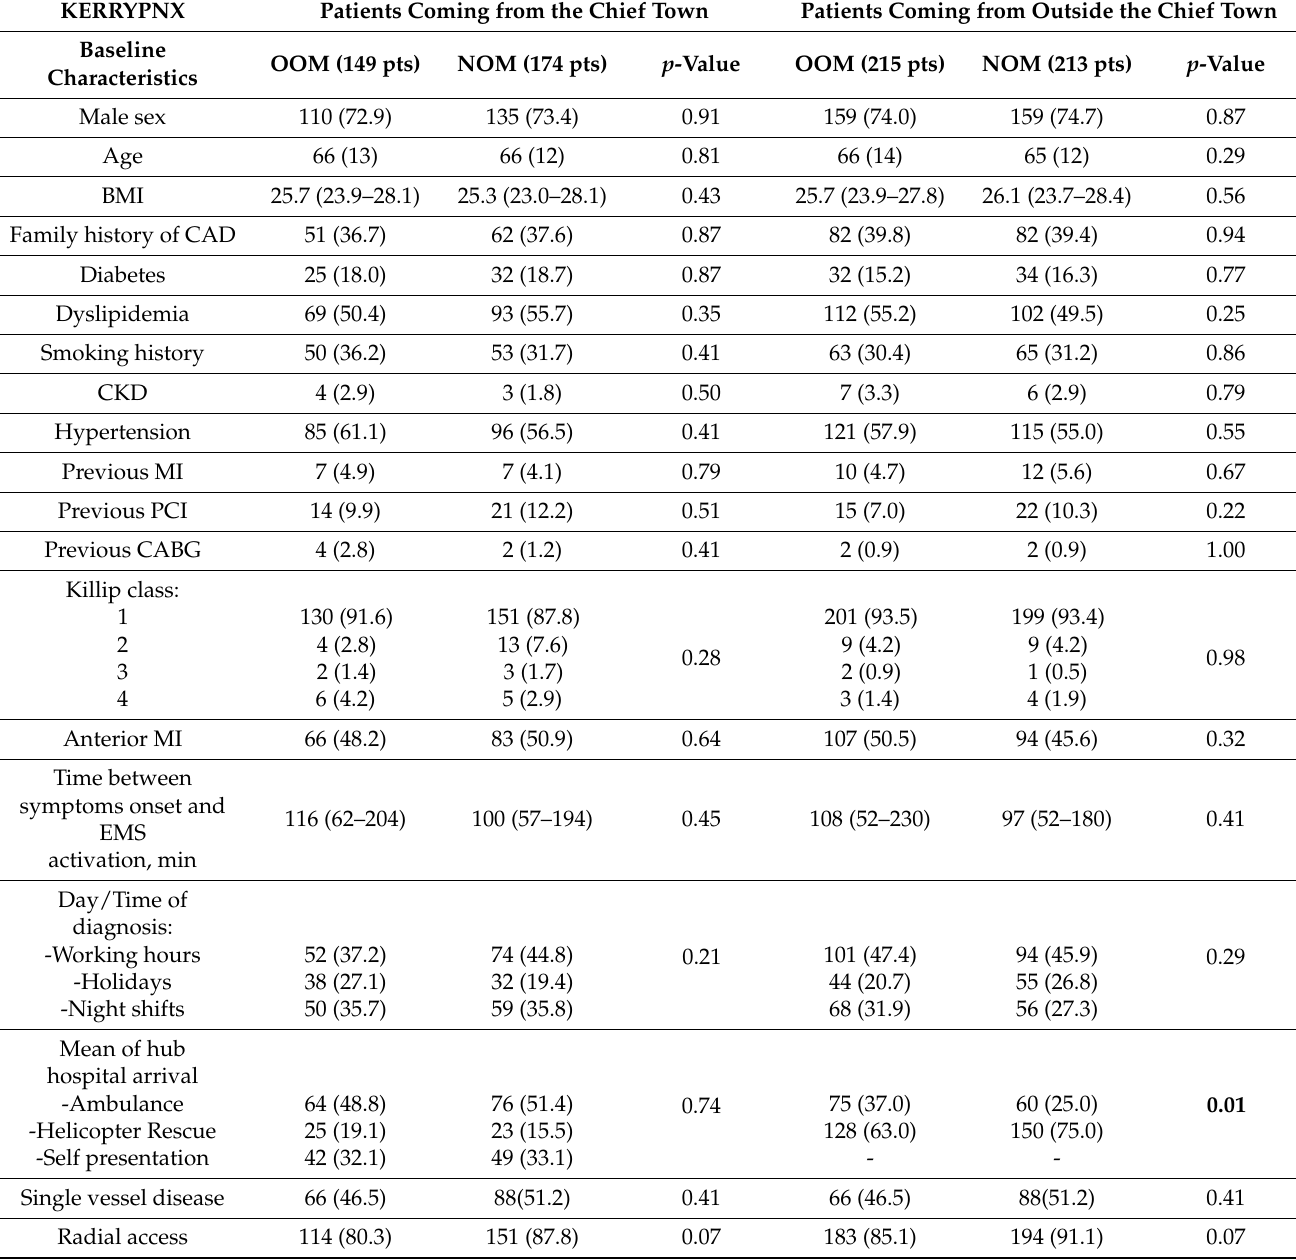
Table 1. Baseline characteristics according to the two different territorial areas in the old and in the new organizational